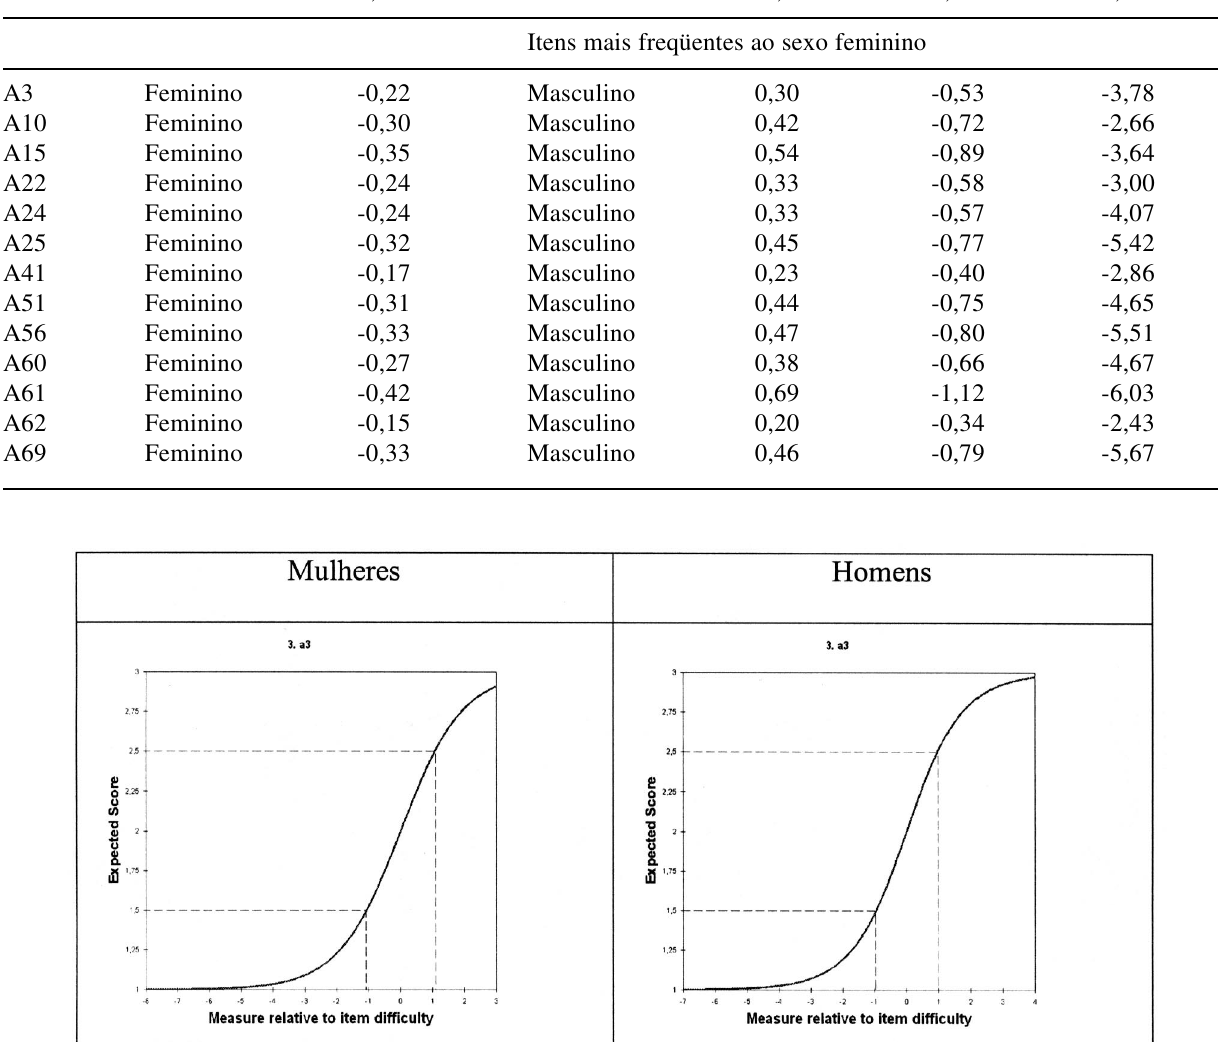
Figura 1. Curva Característica do item